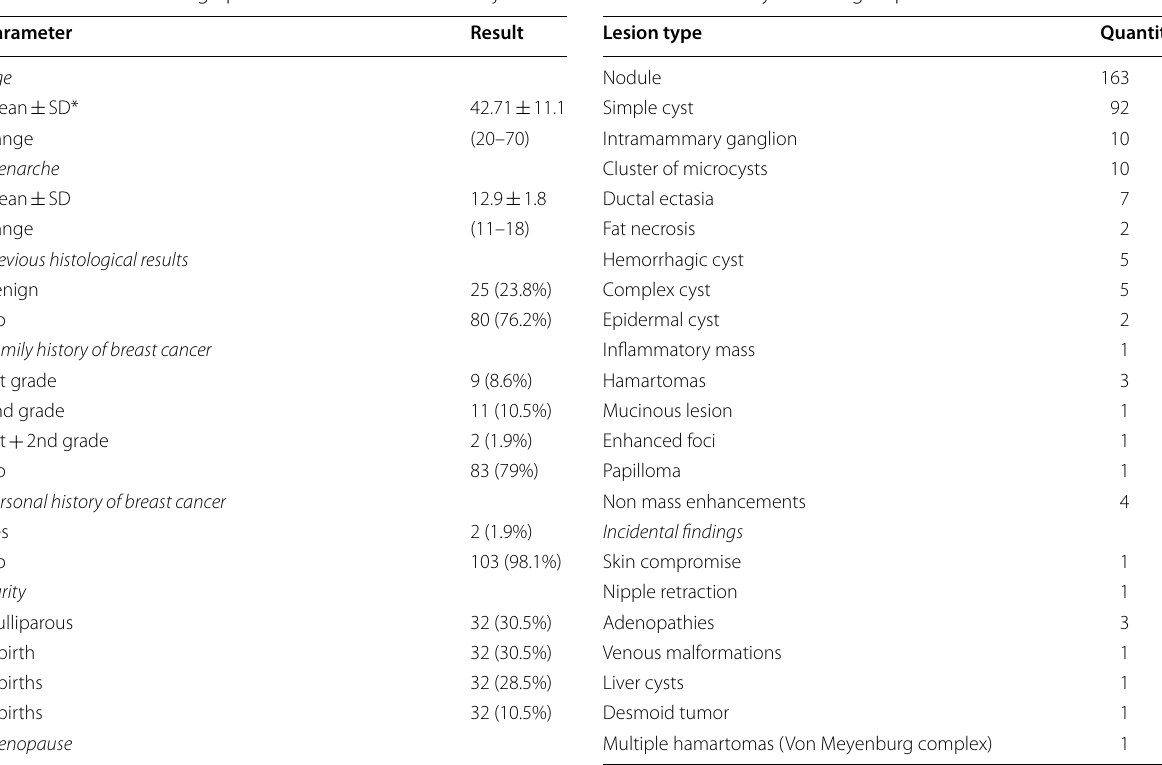
Table 2 Baseline demographics in the cohort of 105 subjects